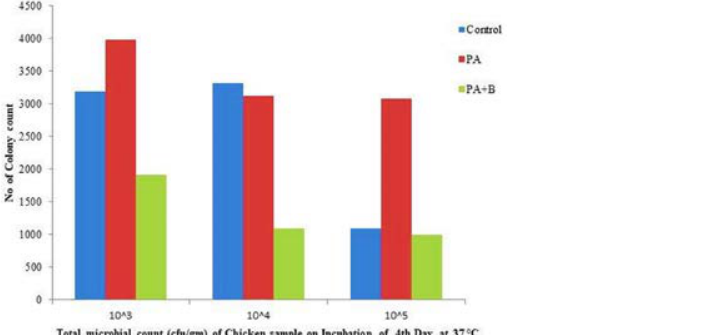
Fig. 2.2. Total microbial count of Chicken meat sample treated with strain and phage on 4 th day of Incubation at 37 °C